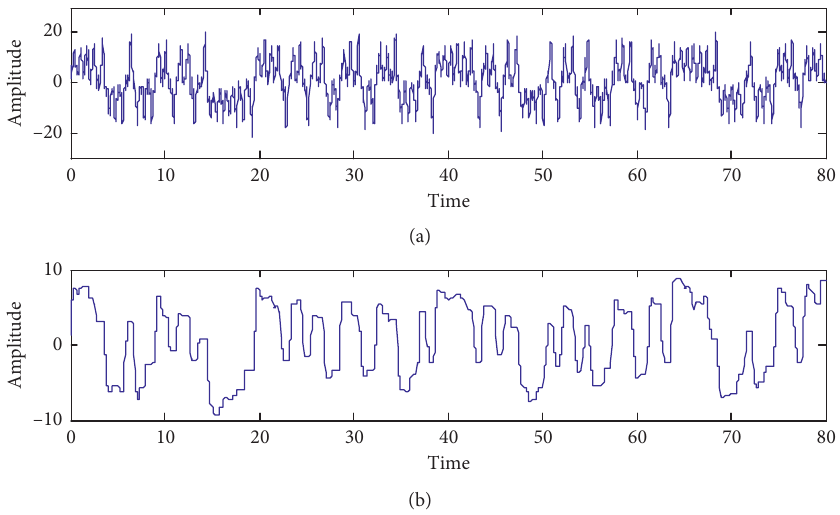
Figure 3: Time domain waveform of (a) morphological filtering result at scale 1 and (b) morphological filtering result at scale